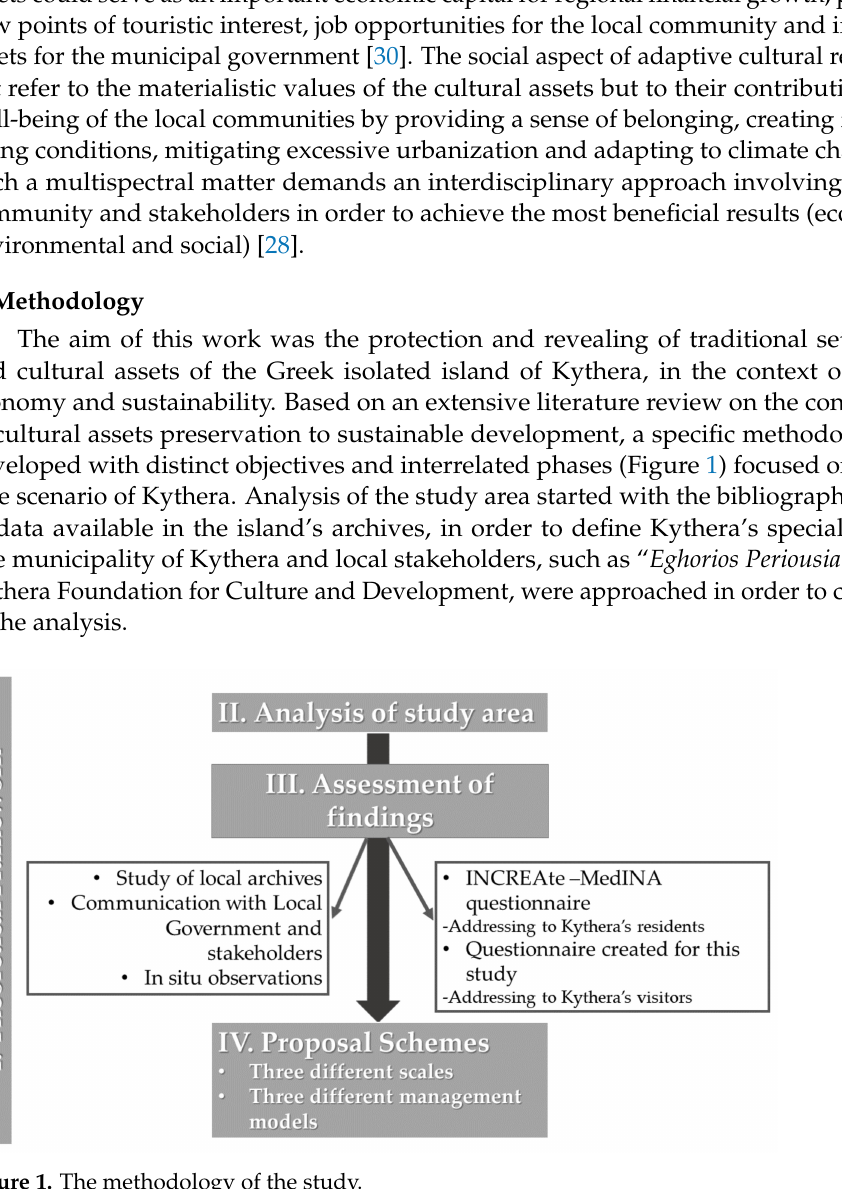
Figure 1. The methodology of the